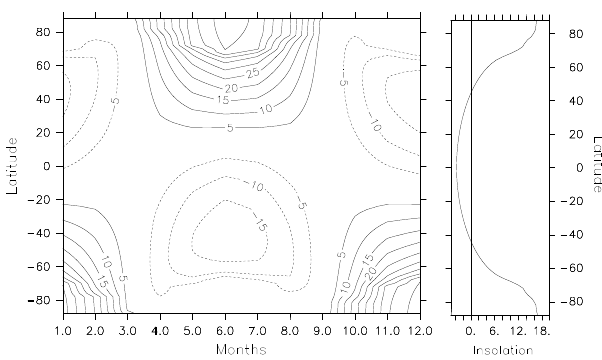
Figure 1. Insolation difference between T max (24.45 ◦ , T for tilt) and T min (22.05 ◦ ). On the left, insolation difference in Wm − 2 is given per month on the x axis and latitude on the y axis. On the right, annual mean insolation difference is given, also in Wm − 2